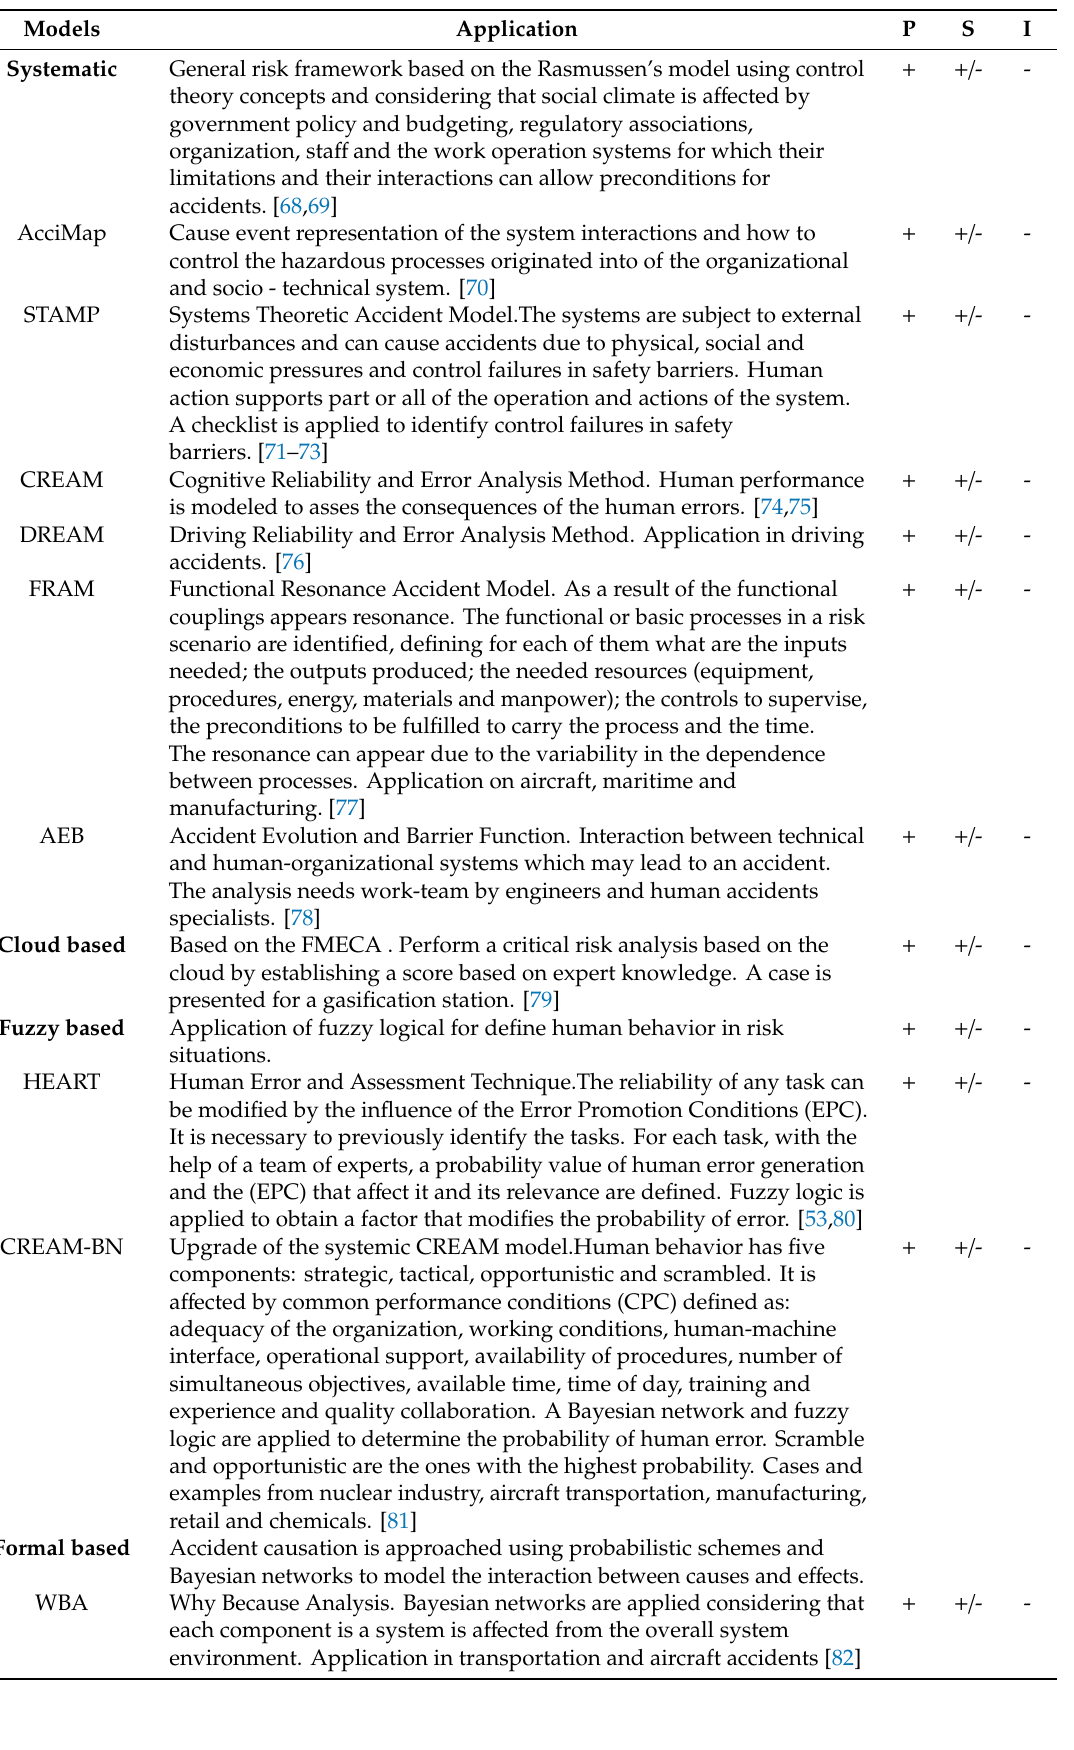
Table 3. Existing modern